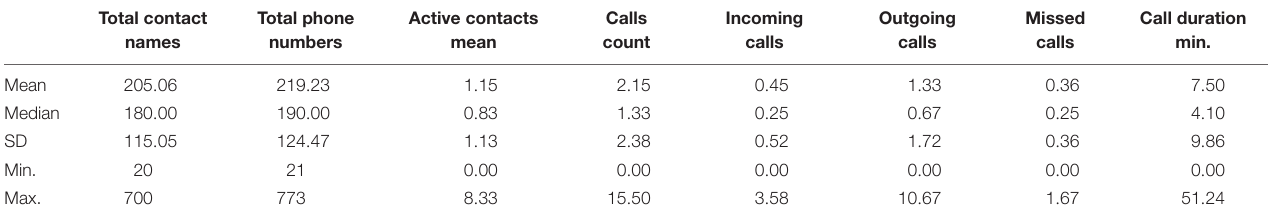
TABLE 1 | Descriptive statistics for the investigated